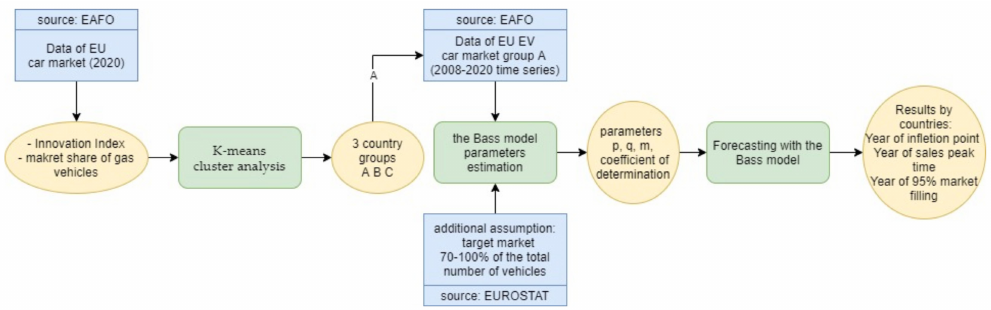
Figure 1. Methodology of the research and subsequent stages of the proceedings [own